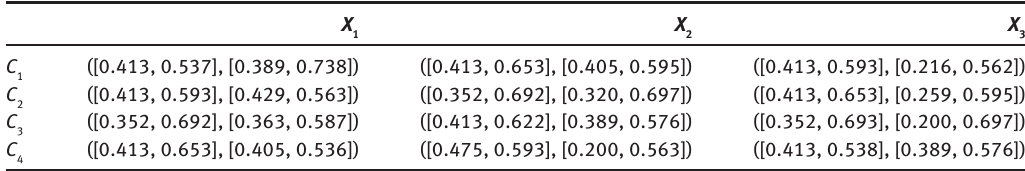
Table 7: Collective Interval-Valued Pythagorean Fuzzy Decision Matrix R .